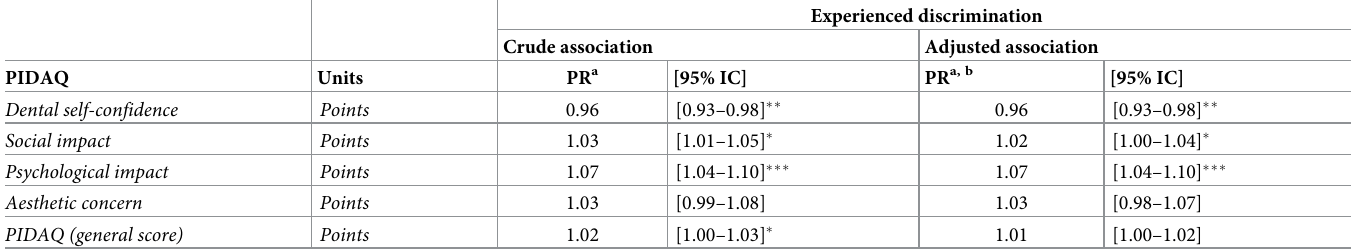
Table 3. Association between the psychosocial impact of dental aesthetics and experiencing discrimination among 207 outpatients from a Peruvian public